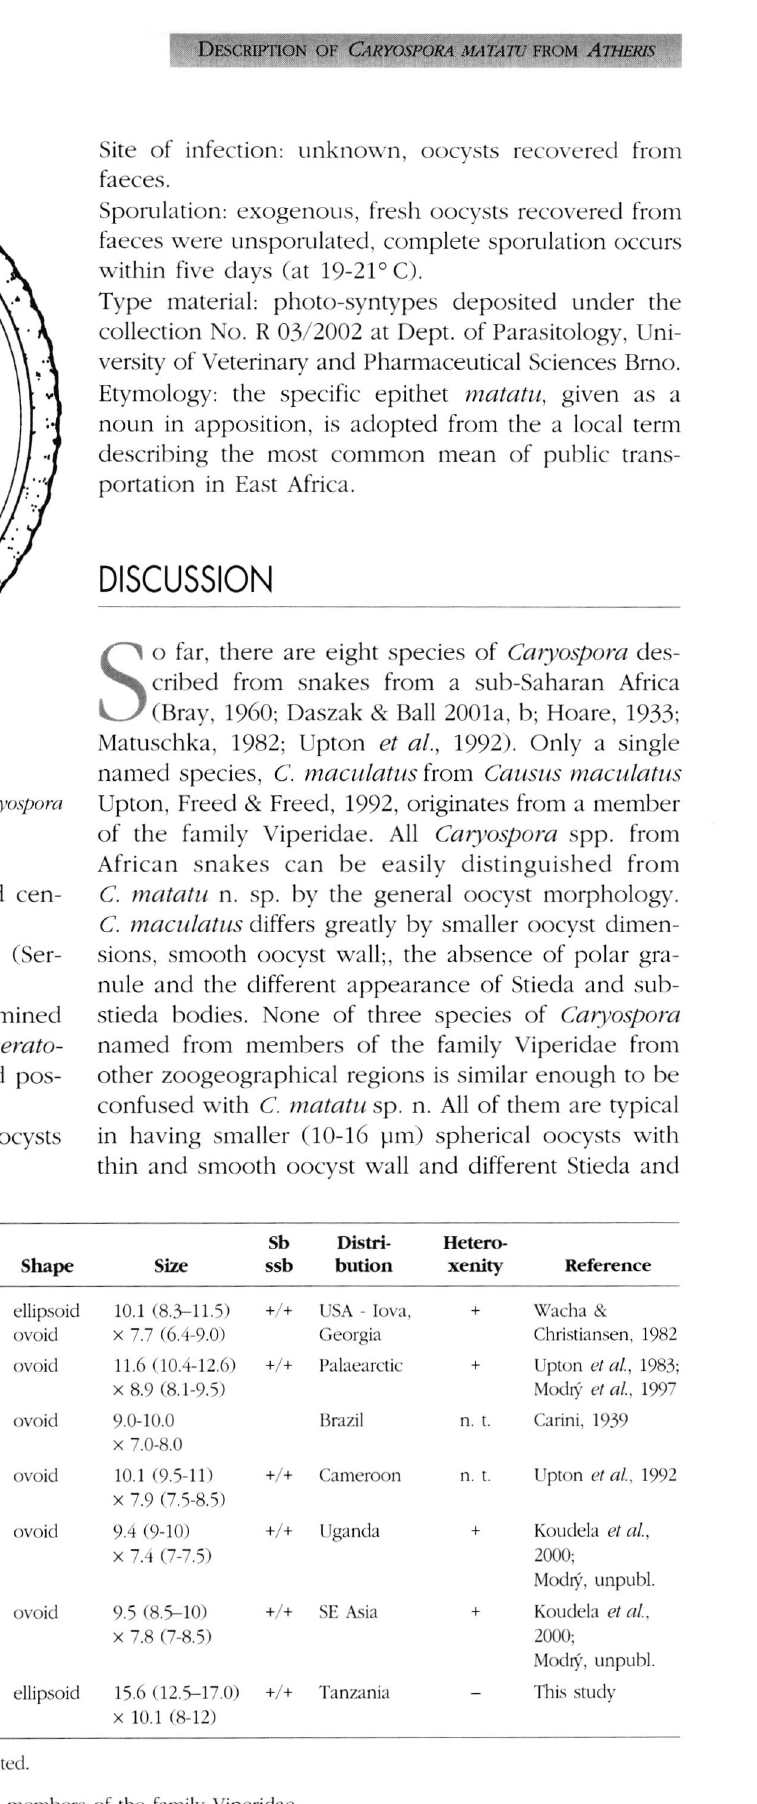
Table I. - Species of Caiyospora Leger. 1904 reported from members of the family